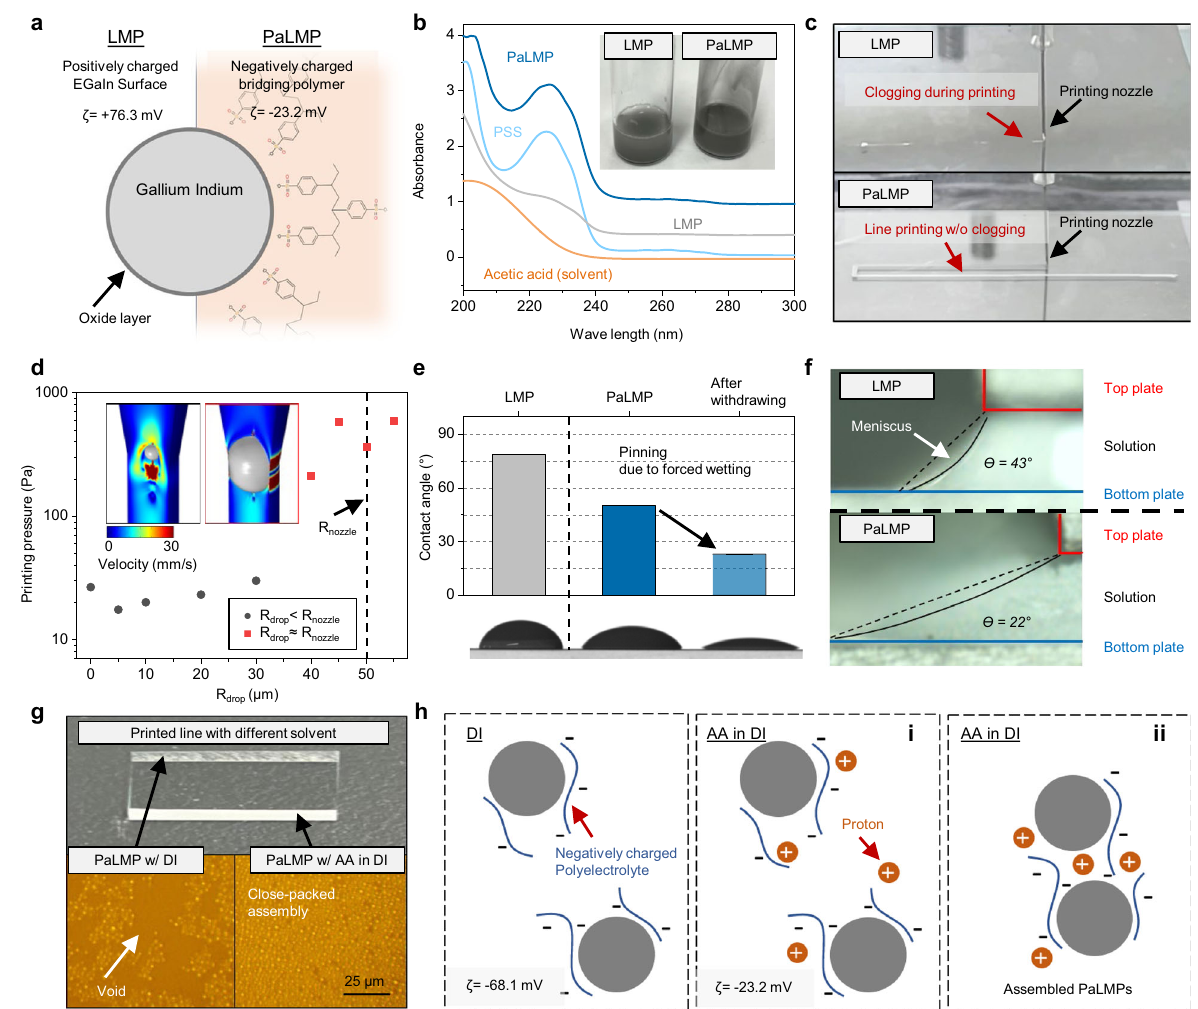
Fig. 2 Chemical con fi guration and characterization of PaLMP-based ink. a Schematic illustration and zeta potential of liquid metal particles (LMP) and PaLMP con fi guration. b UV-vis spectra of ink according to various combinations. Inset: Photograph of each ink c Photograph of MGP with LMP and PaLMP- based ink. LMP-based ink is easily clogged. d The printing pressure varying the size of liquid metal drop. Inset rainbow bar is linear from 0 to 30 mm/s. e Contact angles of LMP and PaLMP-based ink, and PaLMP-based ink after withdrawing half of the original volume. f OM side view image of the meniscus formed with LMP and PaLMP-based ink. g Photograph and OM image of printed PaLMP with different solvent. h Schematic illustration of PaLMPs assembly process in different